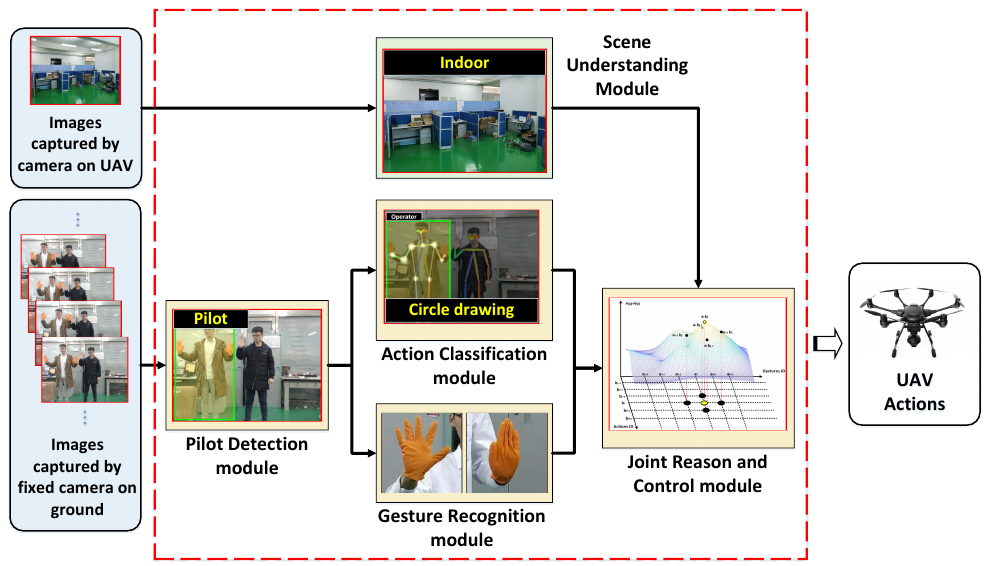
Figure 5. Structure diagram of the system.